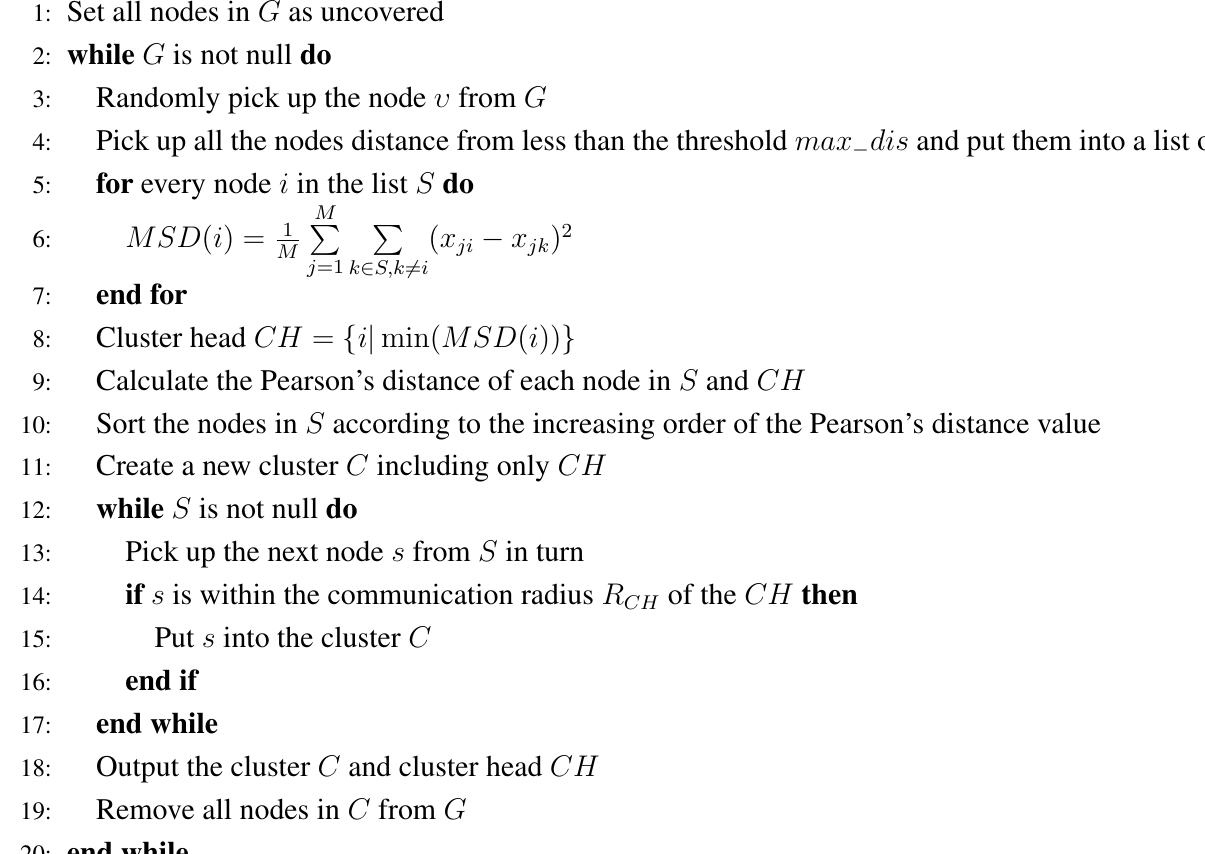
Algorithm 1 works by combining two main operations: cluster formation and cluster head selection. Two metrics (Euclidean and Pearson’s distance) are used to group together nodes with high